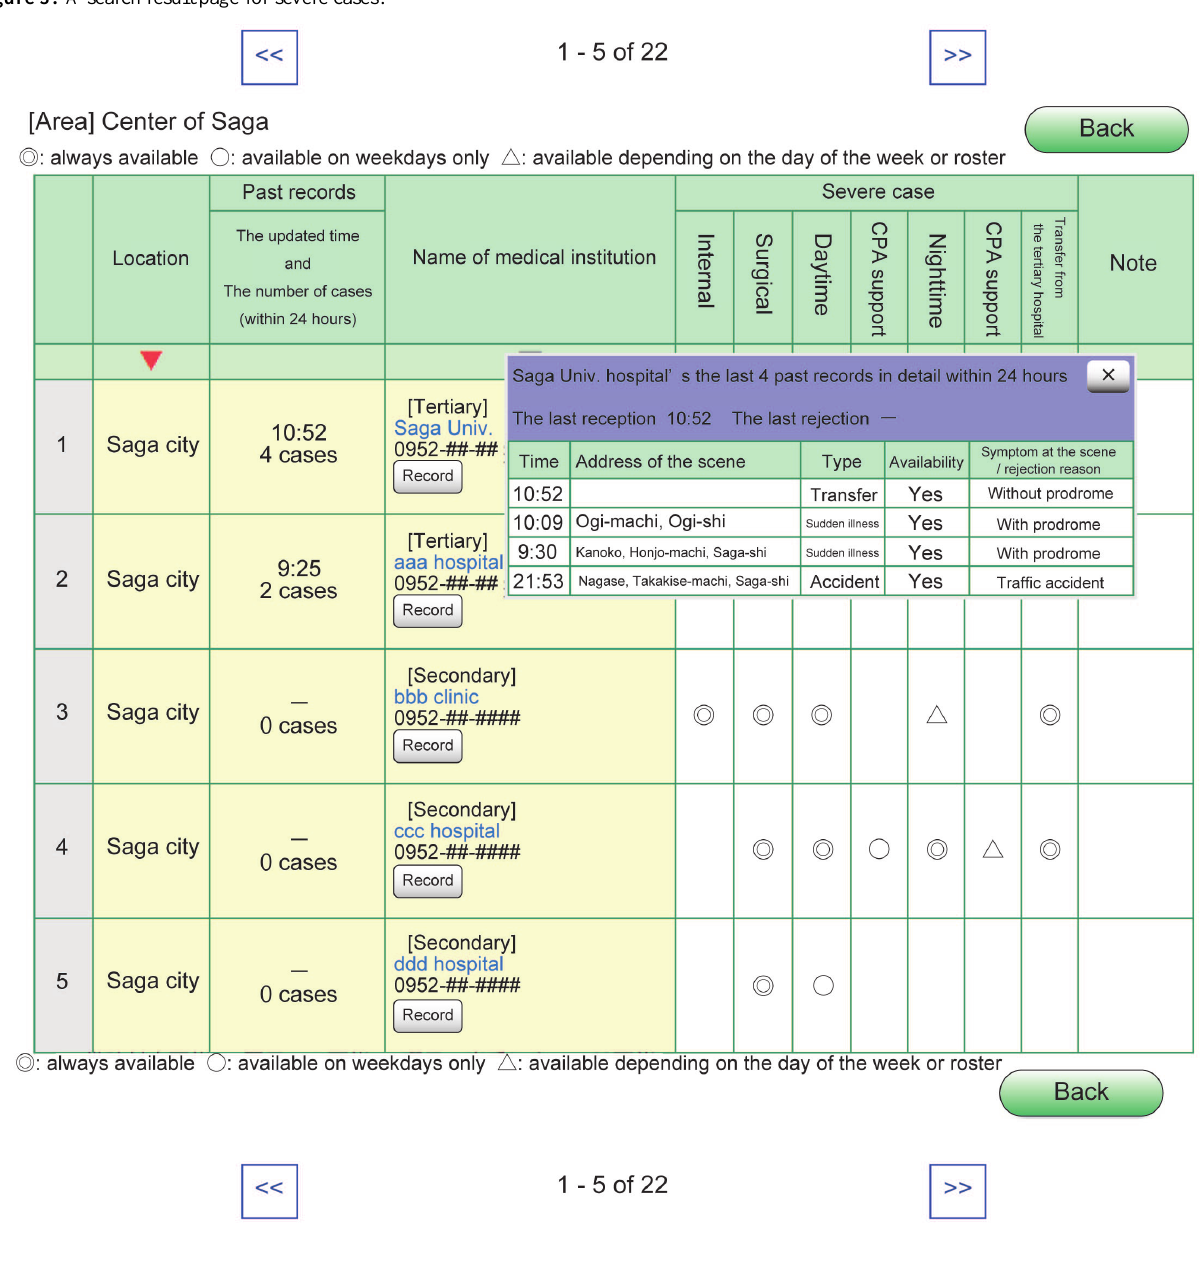
Figure 3. A search result page for severe